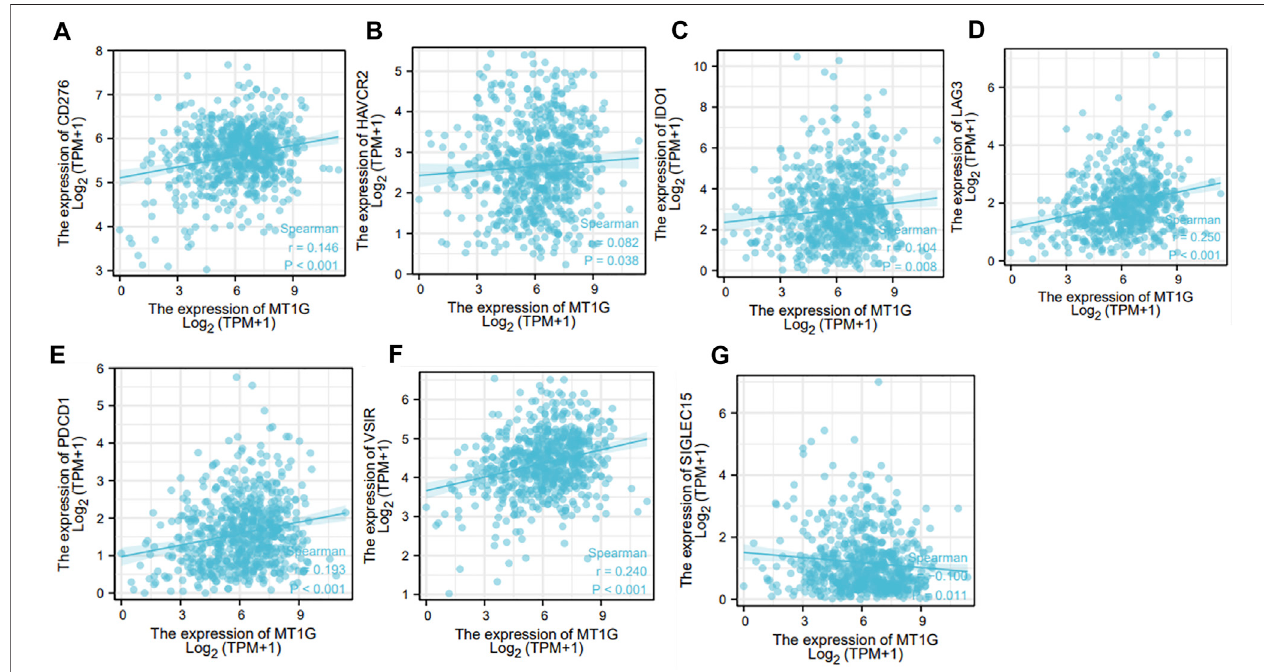
FIGURE 7 | Association between MT1G and several immune checkpoints. (A – G) Several immune checkpoints, such as (A) CD267, (B) HAVCR2, (C) IDO1, (D) LAG3, (E) PDCD1, (F) VSIR, and (G) SIGLEC15, displayed signi fi cant association with the MT1G expression in CRC.